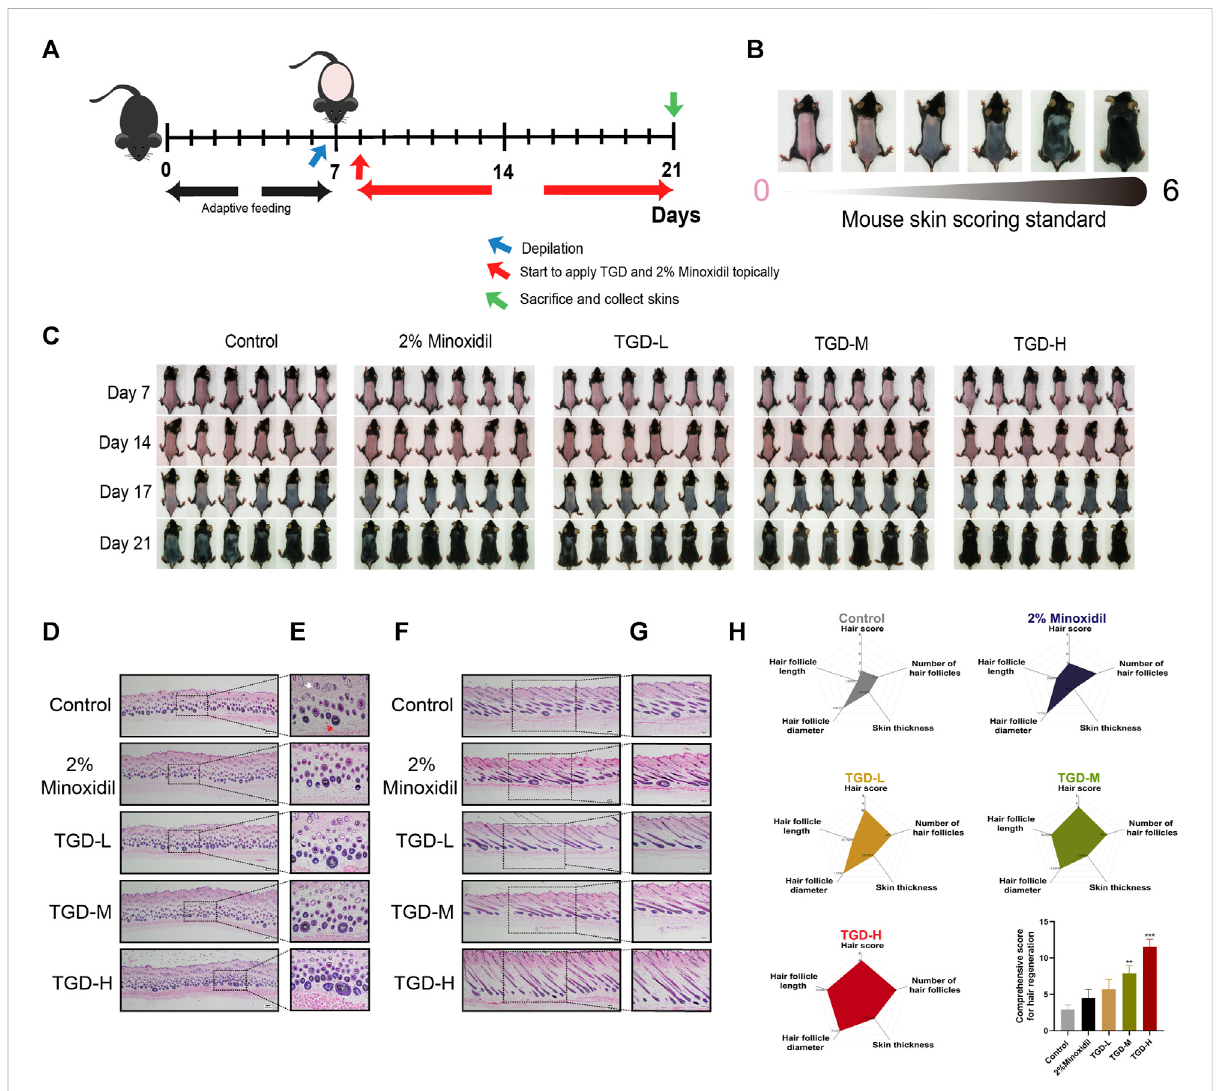
H&E staining of full-thickness skin, (D,F) with magni fi cation ×40. (E) with magni fi cation × 200. (G) with magni fi cation ×100. (D,E) Representative microimagesofskincrosssectionsand (F,G) skinlongitudinalsections.Whitearrowpointtotelogenfollicles.Redarrowpointtoanagenfollicle. (H) Comprehensive score for hairregeneration ( n =5). Data werepresented as mean ±standarderror ofthe mean(SEM). ** p < 0.01, *** p < 0.001 vs. the control